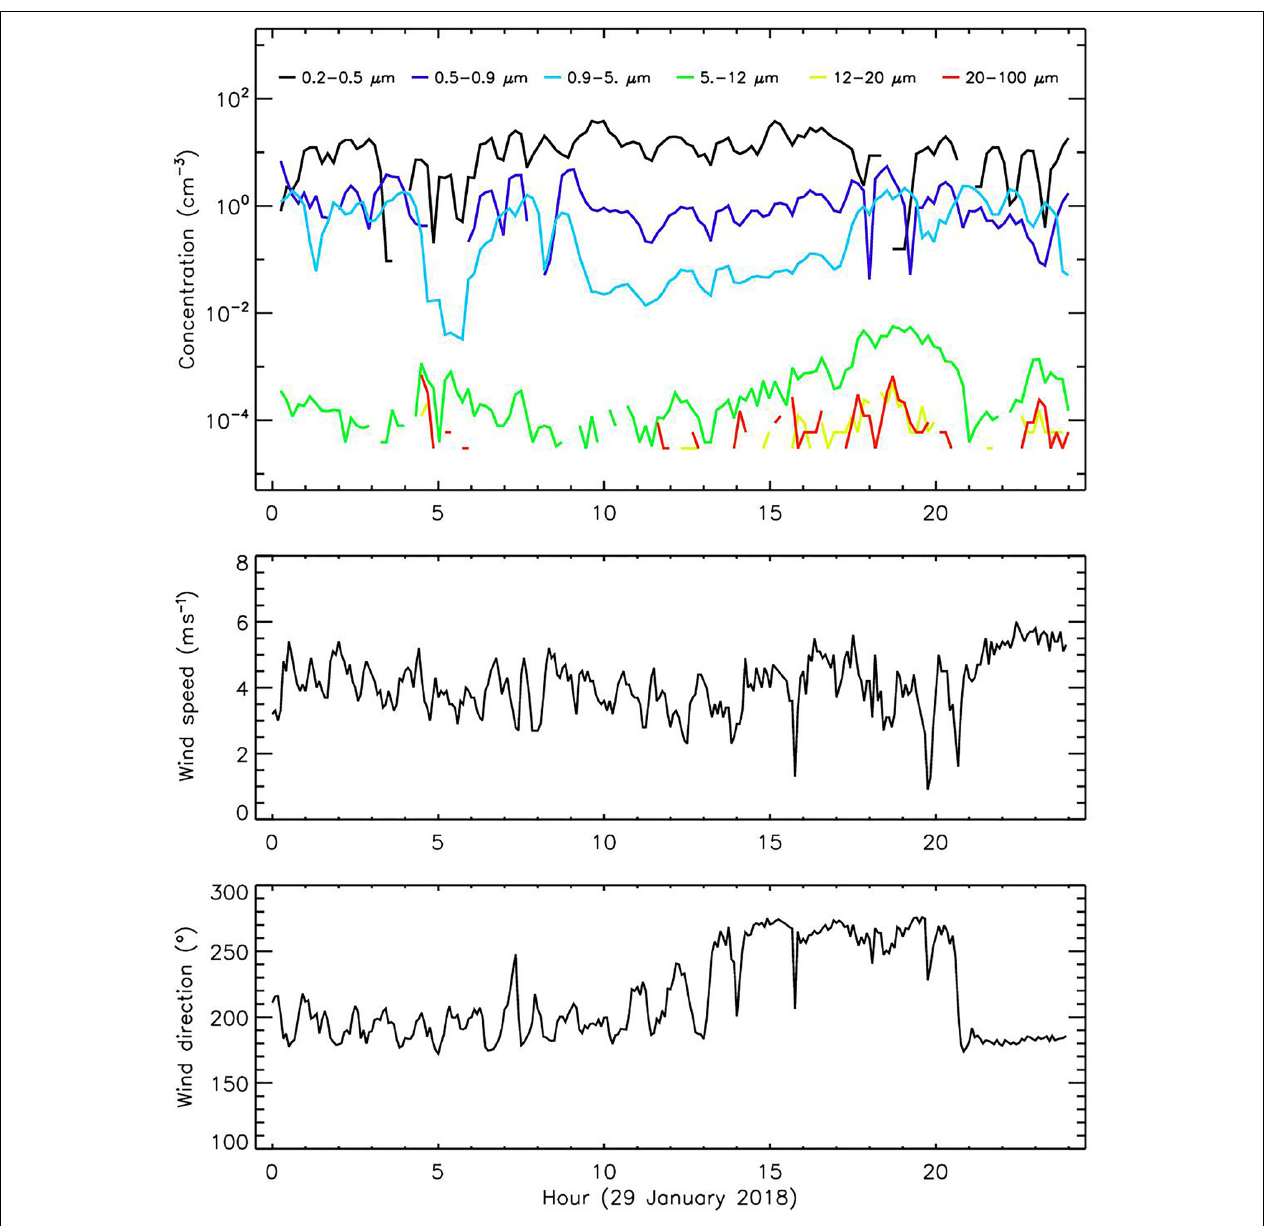
FIGURE 13 | 29 January 2018 wind conditions and aerosol